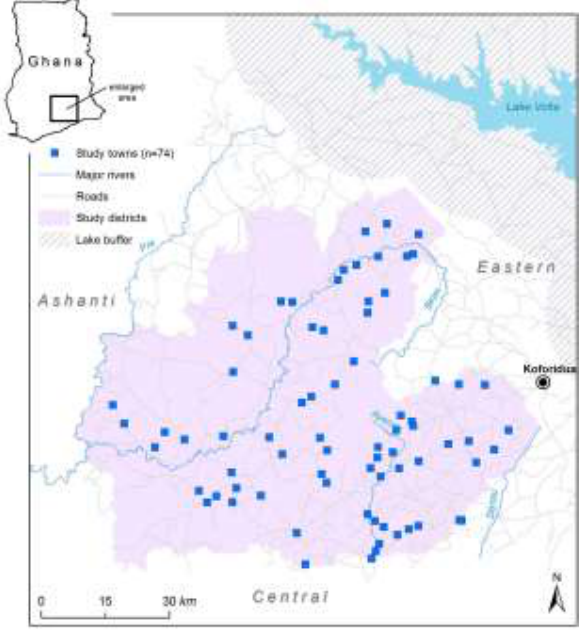
Figure 1: Map of study